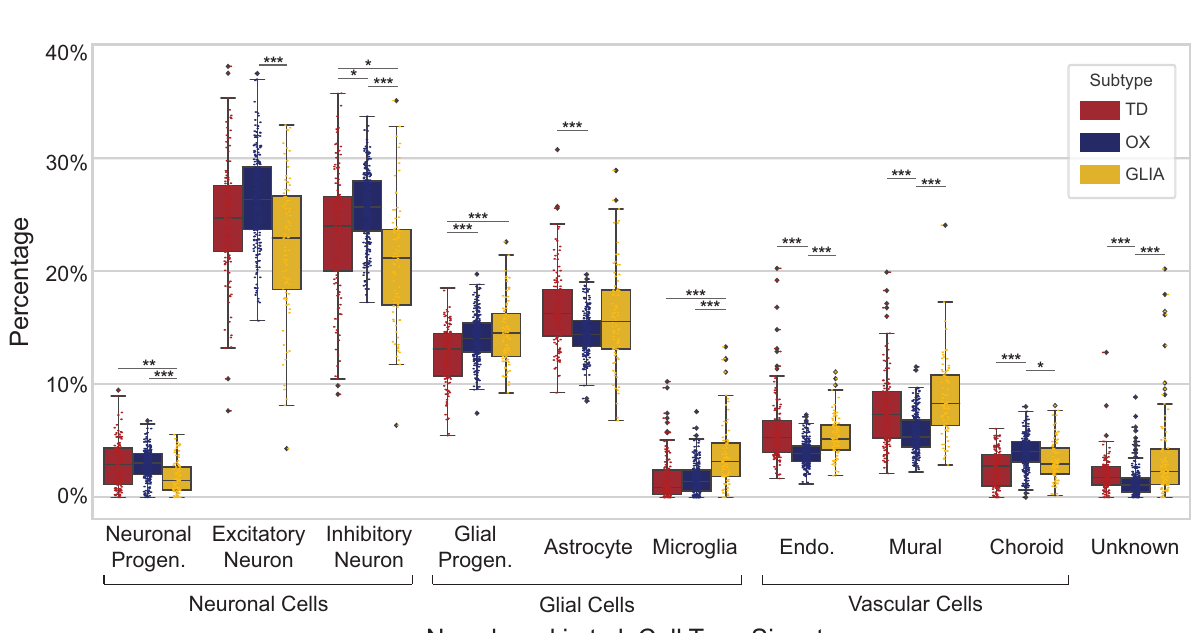
fi rstandthirdquartilesarecapturedbytheboundsofthebox.Boxplotwhiskersare de fi ned as the fi rst and third quartiles ± interquartile range times 1.5, respectively, and outliers are denoted as solid black points. Minimum and maximum values are capturedbythelowermostanduppermostpoints,respectively,orwhiskerboundif no outliers are shown. Source data are provided as a Source Data fi le, including exact p- values for all